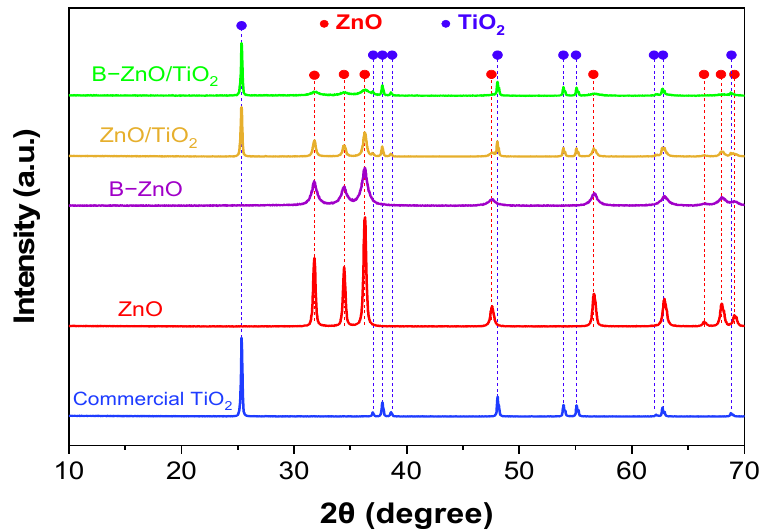
Figure 1. XRD diffraction patterns of TiO 2 , ZnO, B − ZnO, ZnO/TiO 2 , and B − ZnO/TiO 2 . Table 1. Crystallite size, BET parameters, and bandgap energies.